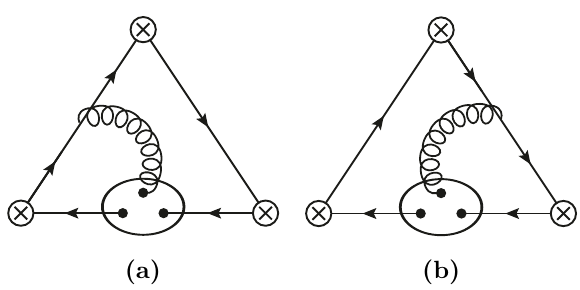
Figure 8. Feynman diagrams of the contributions of the quark-gluon condensate to the three-point Green functions due to the e(cid:11)ective propagation of the non-local quark-gluon condensate